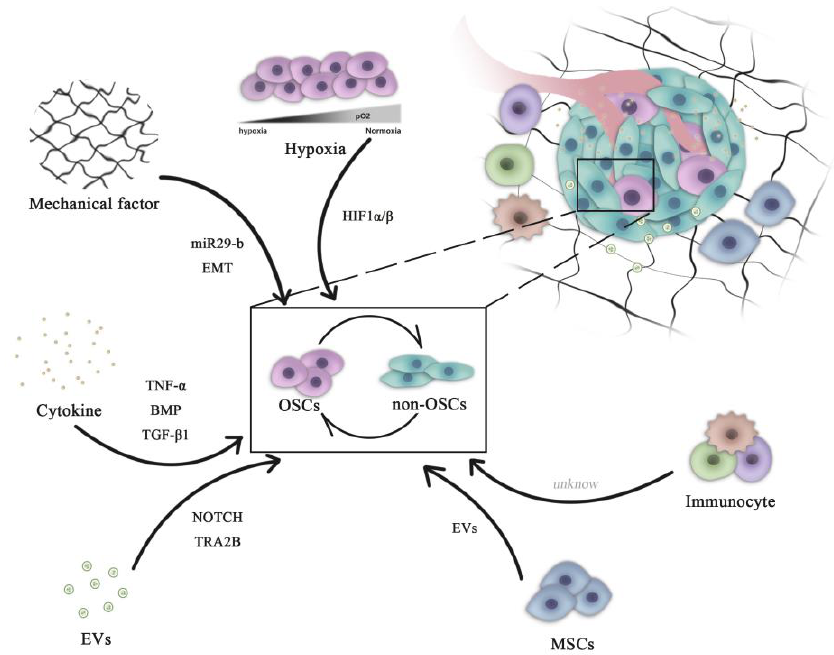
Figure 1. Role of microenvironment signaling in regulating OSC and non-OSC reversion. Complex pathways are necessary for the maintenance of the homeostasis of the OSC population. All microenvironment components, including cells (mesenchymal cells and immune cells) and non-cellular factors (hypoxia, cytokines and mechanical EVs), can influence the dynamic transition between OSCs and non-OSCs. OSCs, osteosarcoma stem cells; miR, microRNA; HIF, hypoxia-inducible factor; EVs, extracellular vesicles; EMT, epithelial-mesenchymal transition; BMP, bone morphogenetic protein; TNF, tumor necrosis factor; TGF, transforming growth factor; TRA2B, transformer 2 β homolog.